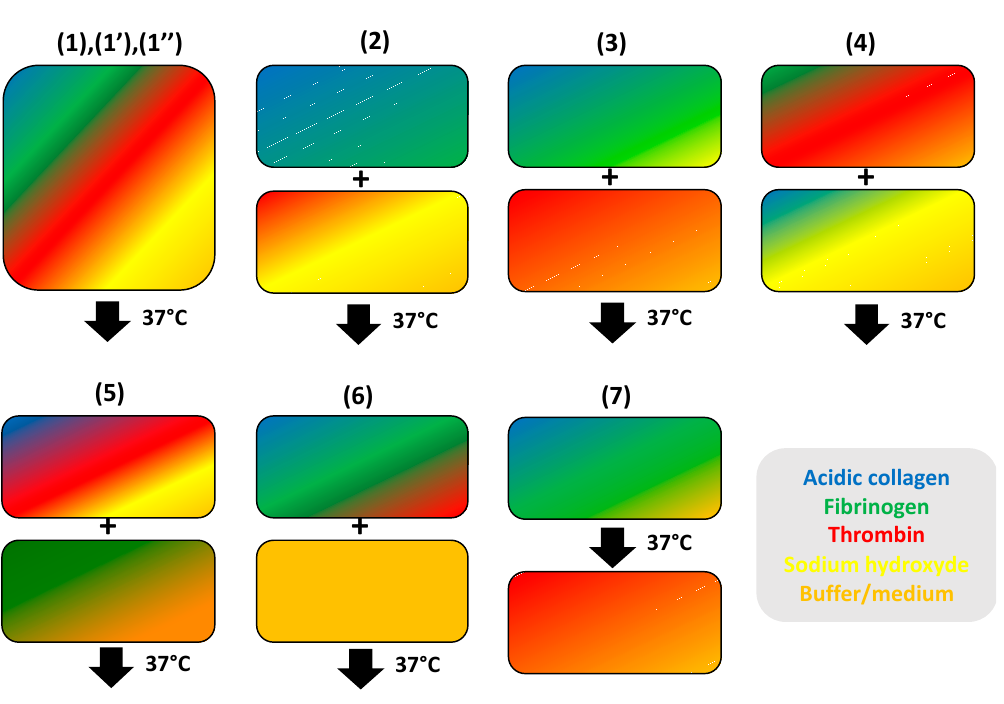
Figure 4. Schematic representation of various reported protocols for the preparation of mixed type I collagen-fibrin hydrogels from protein mixtures. Each component is represented by a color code, as indicated in the grey box. Note that in all protocols except ( 7 ), gel formation is always triggered by incubation at 37 ◦ C after all components have been